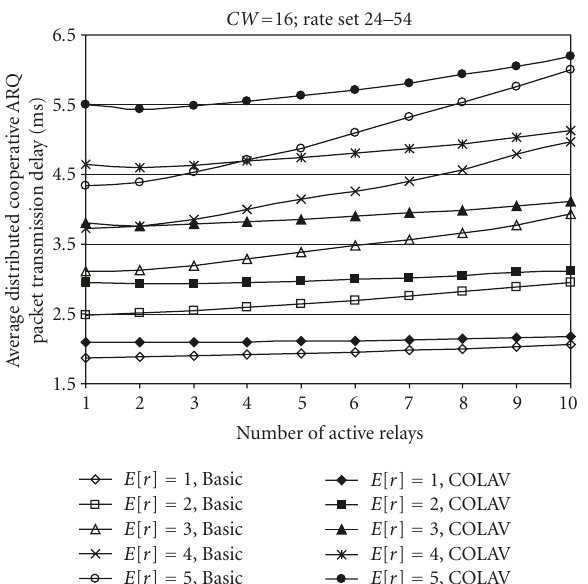
Figure 8: Performance of PRCSMA with di ff erent access methods (BASIC versus COLAV).